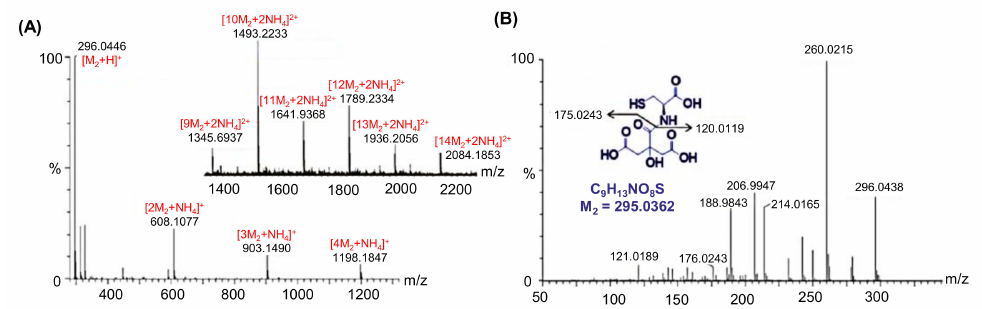
Figure 5. Representation of ( A ) MS spectrum. ( B ) MS/MS spectrum from ESI-TOF-MS analysis of CDs. Inset: MS spectra of the CDs in the higher m/z ranges